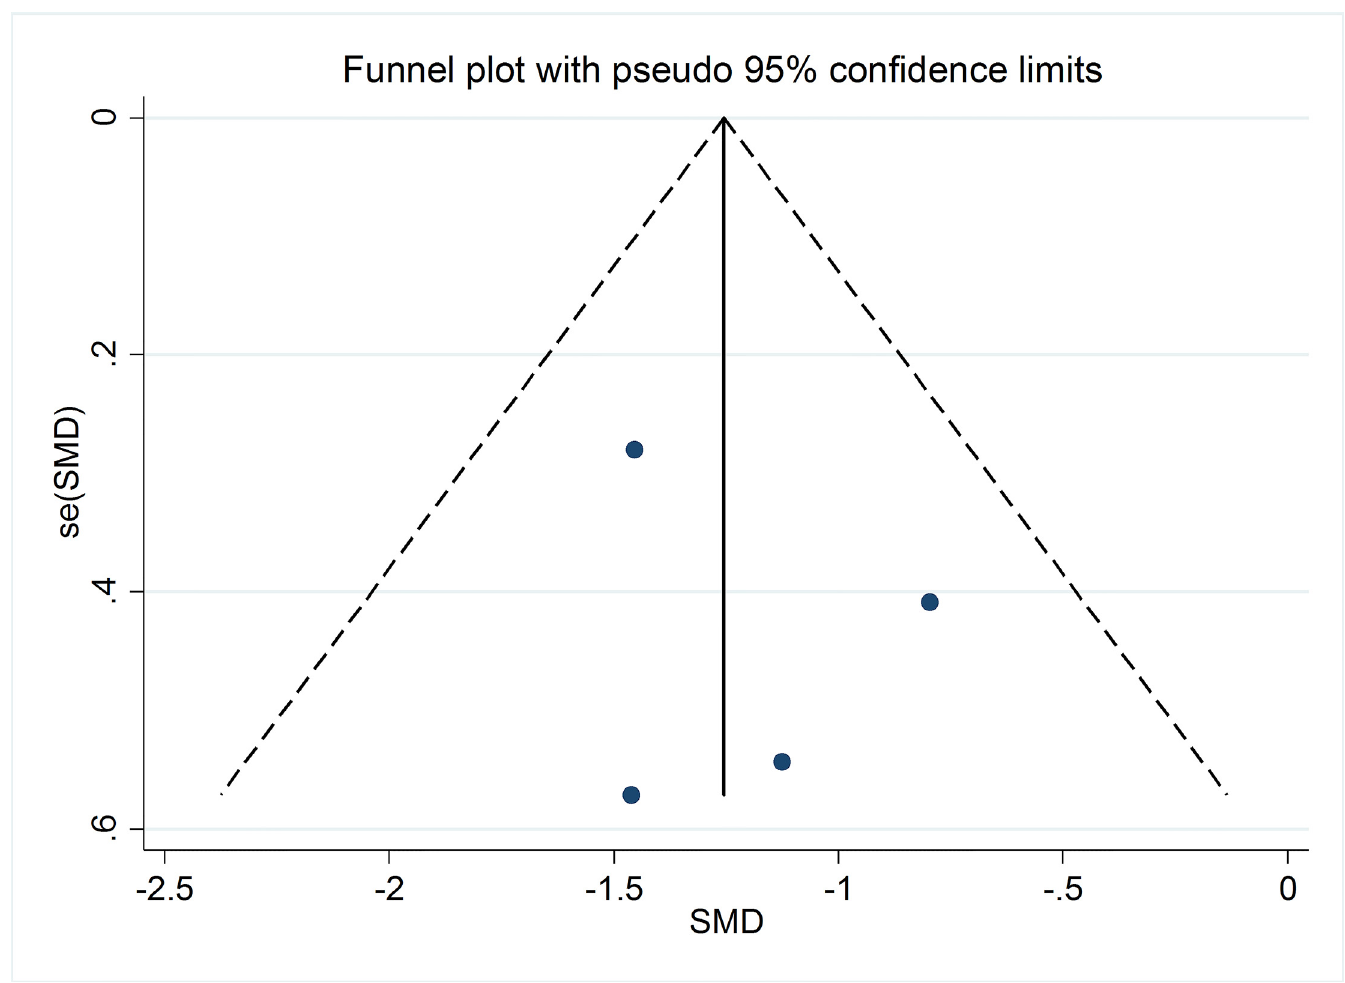
Fig 7. Funnel plot with pseudo 95% confidence limits for studies with TXB